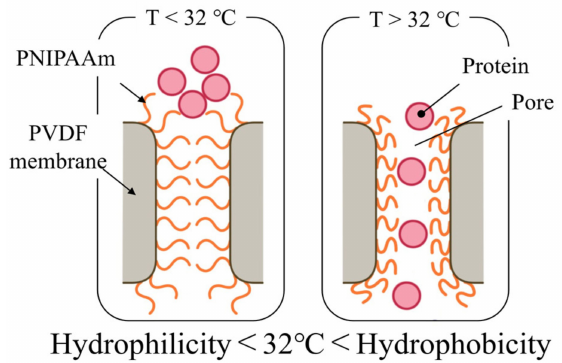
Figure 2. Mechanism of a thermo-responsive valve on a µ PAD for performing